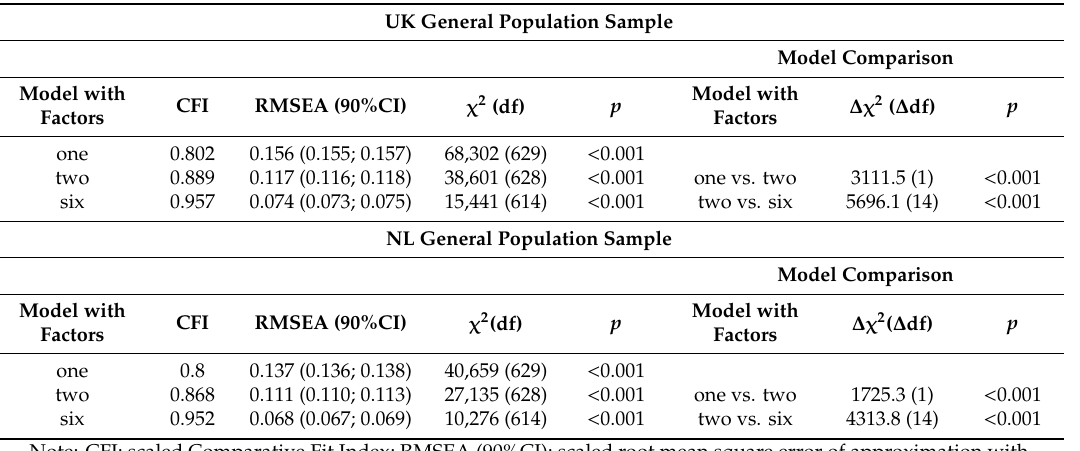
Table A3. Results of confirmatory factor analyses.